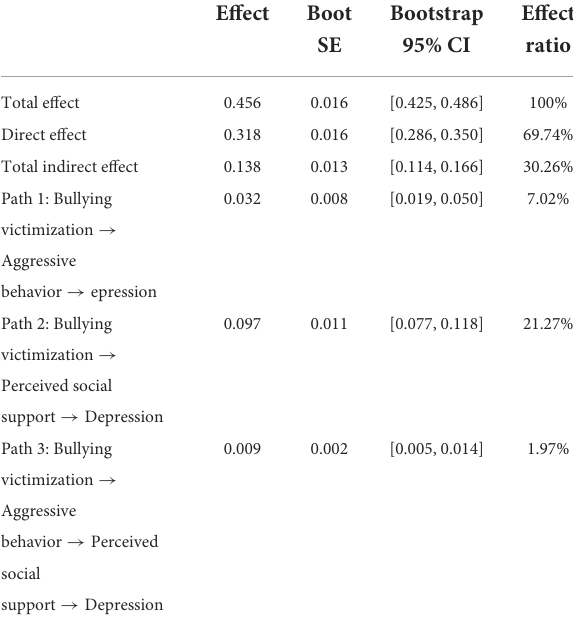
TABLE 4 Mediating effect analysis of bullying victimization and